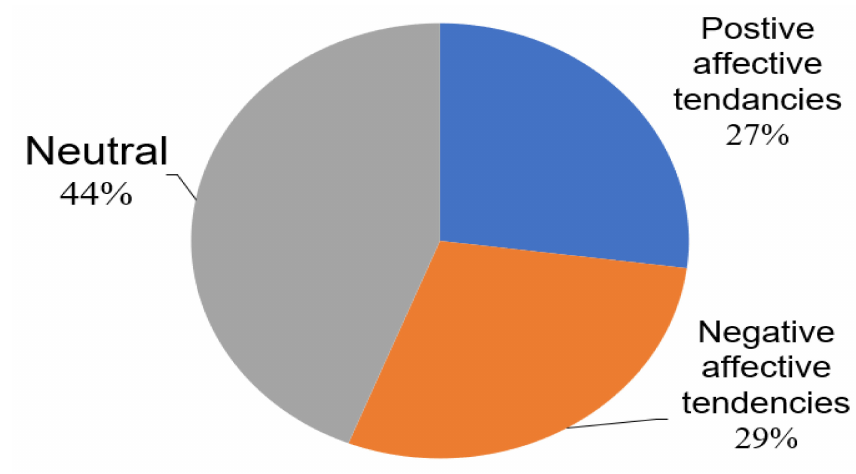
Figure 2. Analysis of the emotional tendencies of the keywords in the sample.